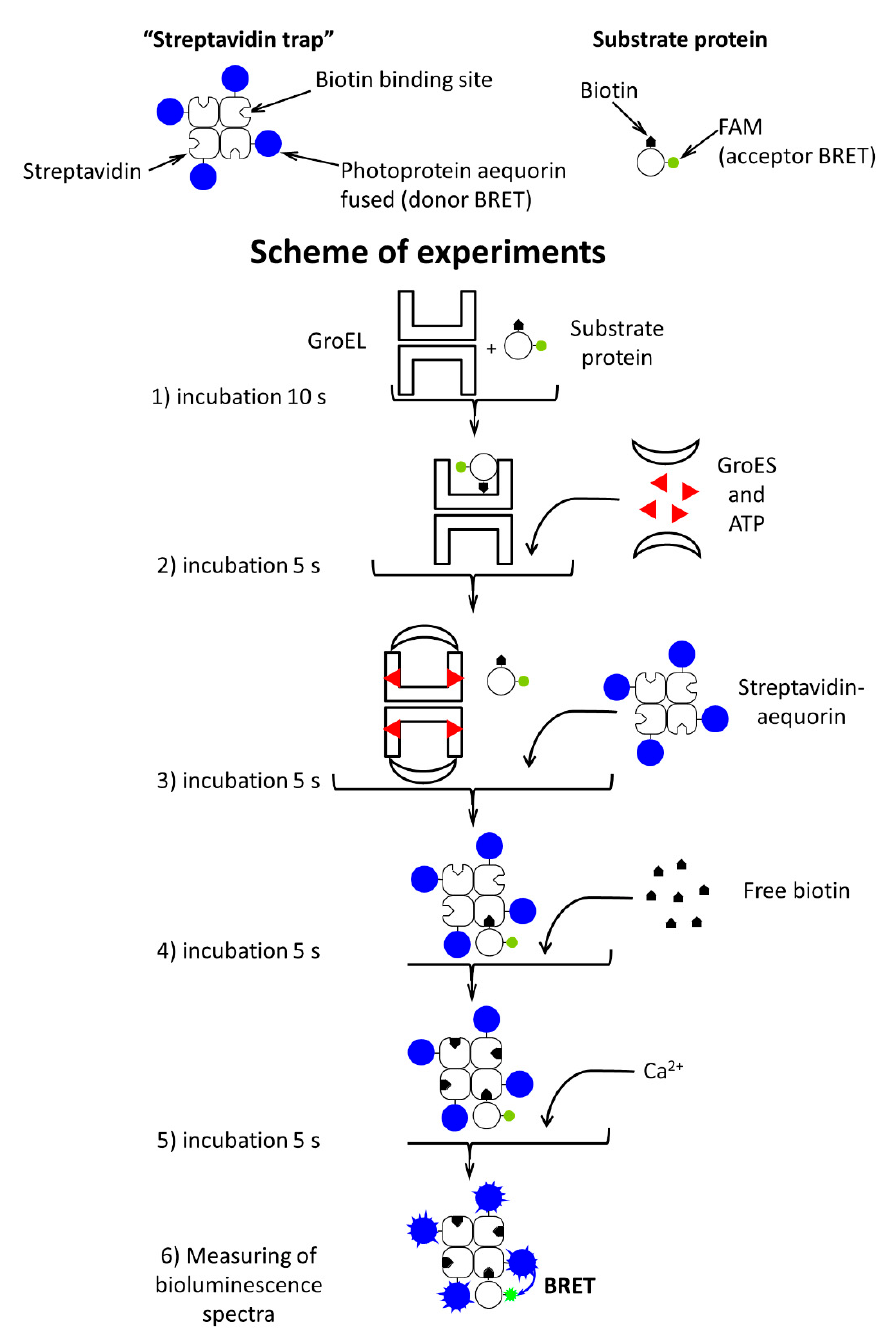
Figure 5. Schematic presentation of experiments using the streptavidin trap.